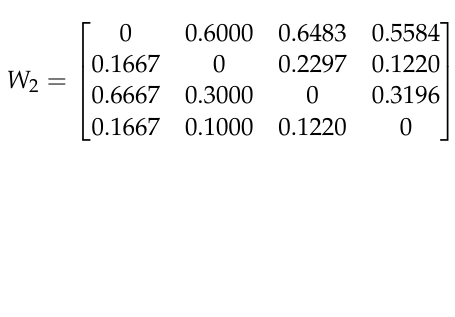
Figure 4. The weight values of SWOT factors and sub-factors.